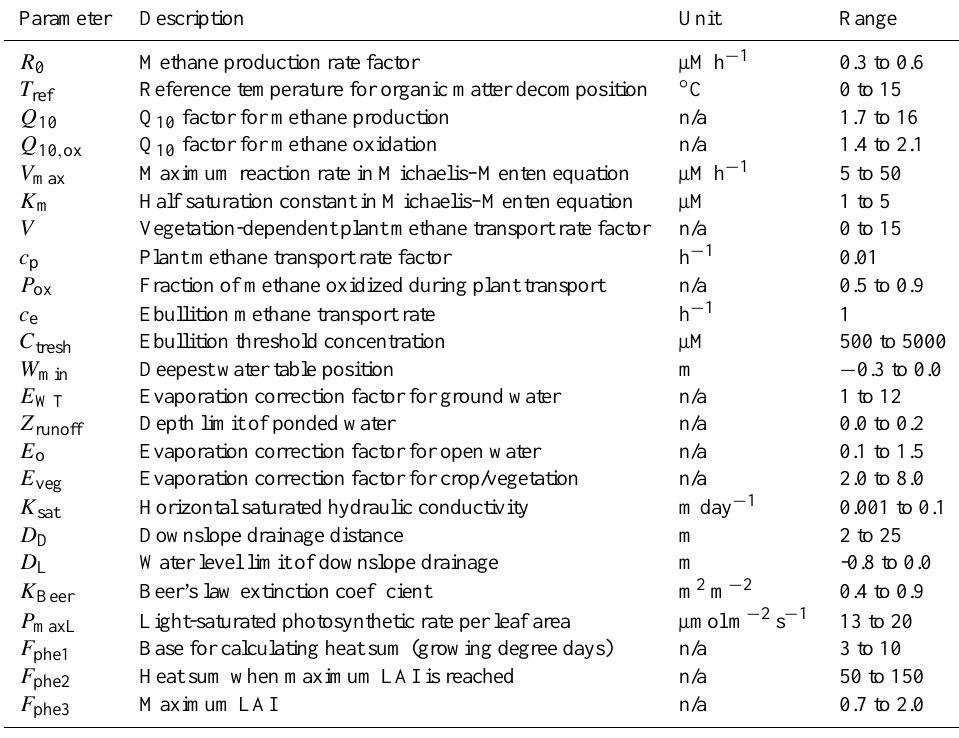
Table 1. Major parameters and their ranges used in Peatland-VU model. Parameter